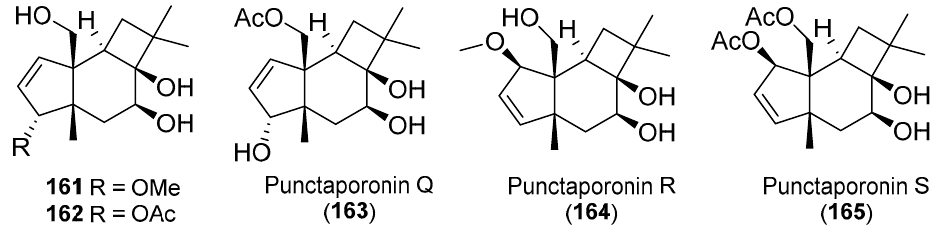
Figure 25. Structures of punctaporonins O–S ( 161 – 165 ) isolated from Cytospora sp.